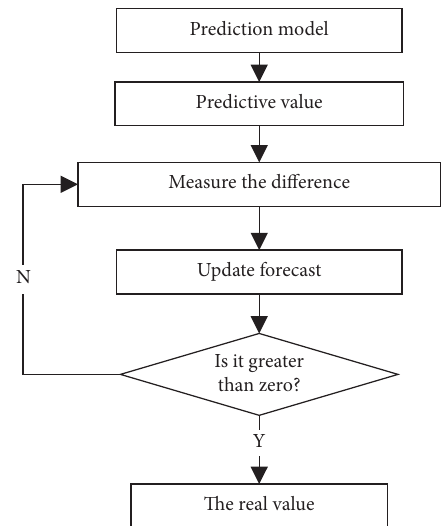
Figure 5: The reconstructed algorithm of the ordinary